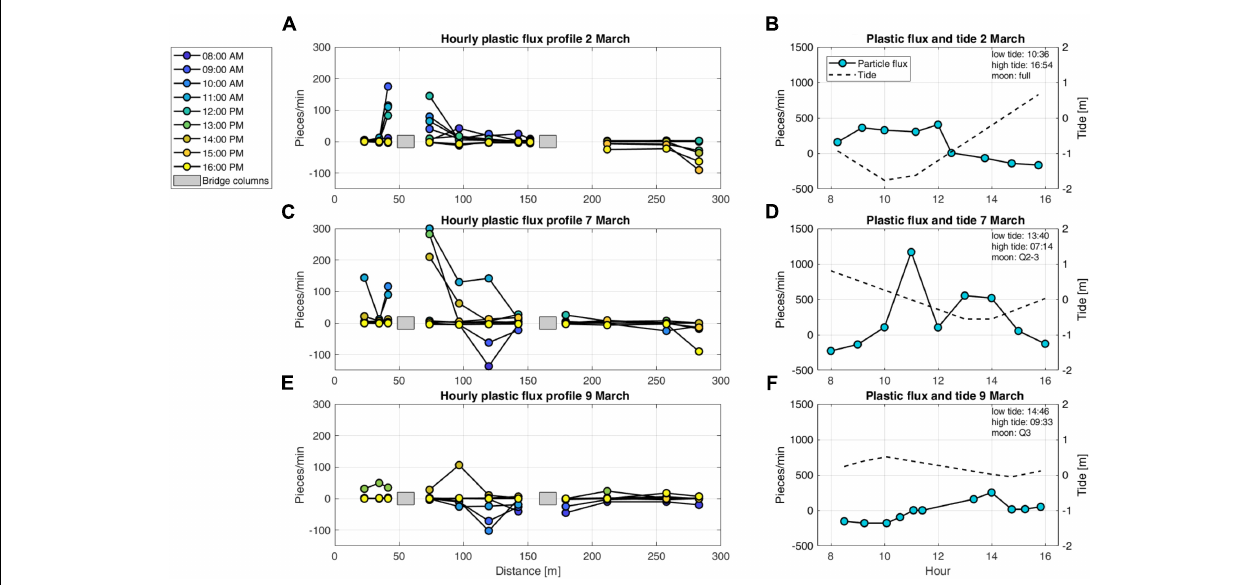
FIGURE 3 | Cross sectional profiles of observed plastic pieces per minute over the river width for 2, 7 and 9 March 2018. (A,C,E) present the plastic flux over the river width with each color representing the time of day. (B,D,F) present the total plastic flux after integration over the river width, including information on high and low tide and the moon phase. The distance runs from measurement location 1 (south) to 12 (north; Figure 2 ), with the southern river bank as reference. Note that a positive plastic flux means ebb tide flow and plastic flux means flood tide flow. The tidal data is expressed as deviation compared to mean water level.